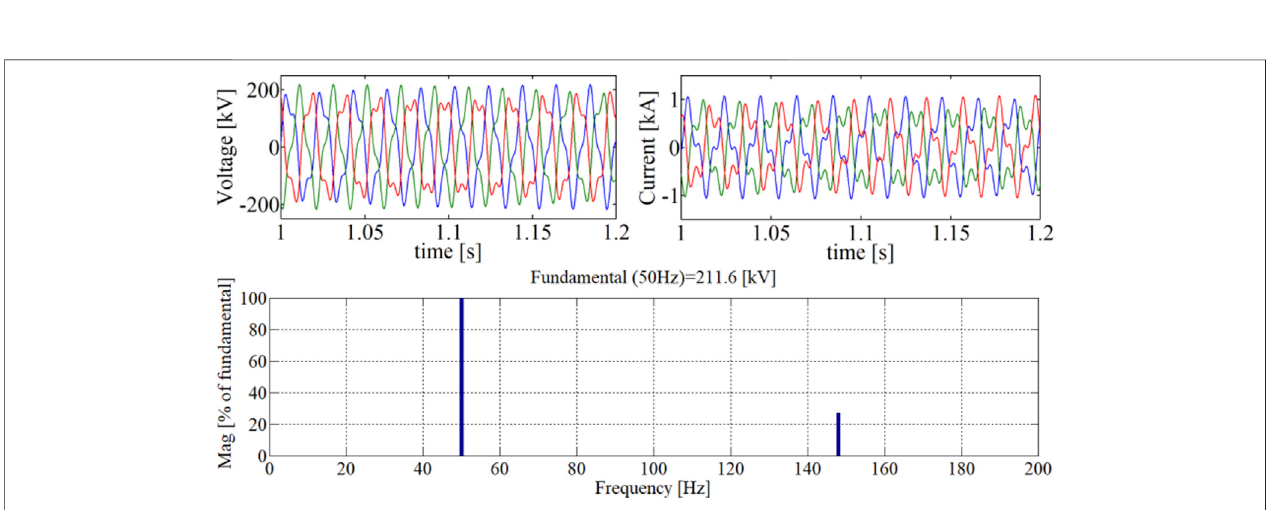
FIGURE 17 | Three-phase voltage and current at the local grid side and the FFT of voltage when the capacity ratio is 80%. SCR (cid:2) 5.0.